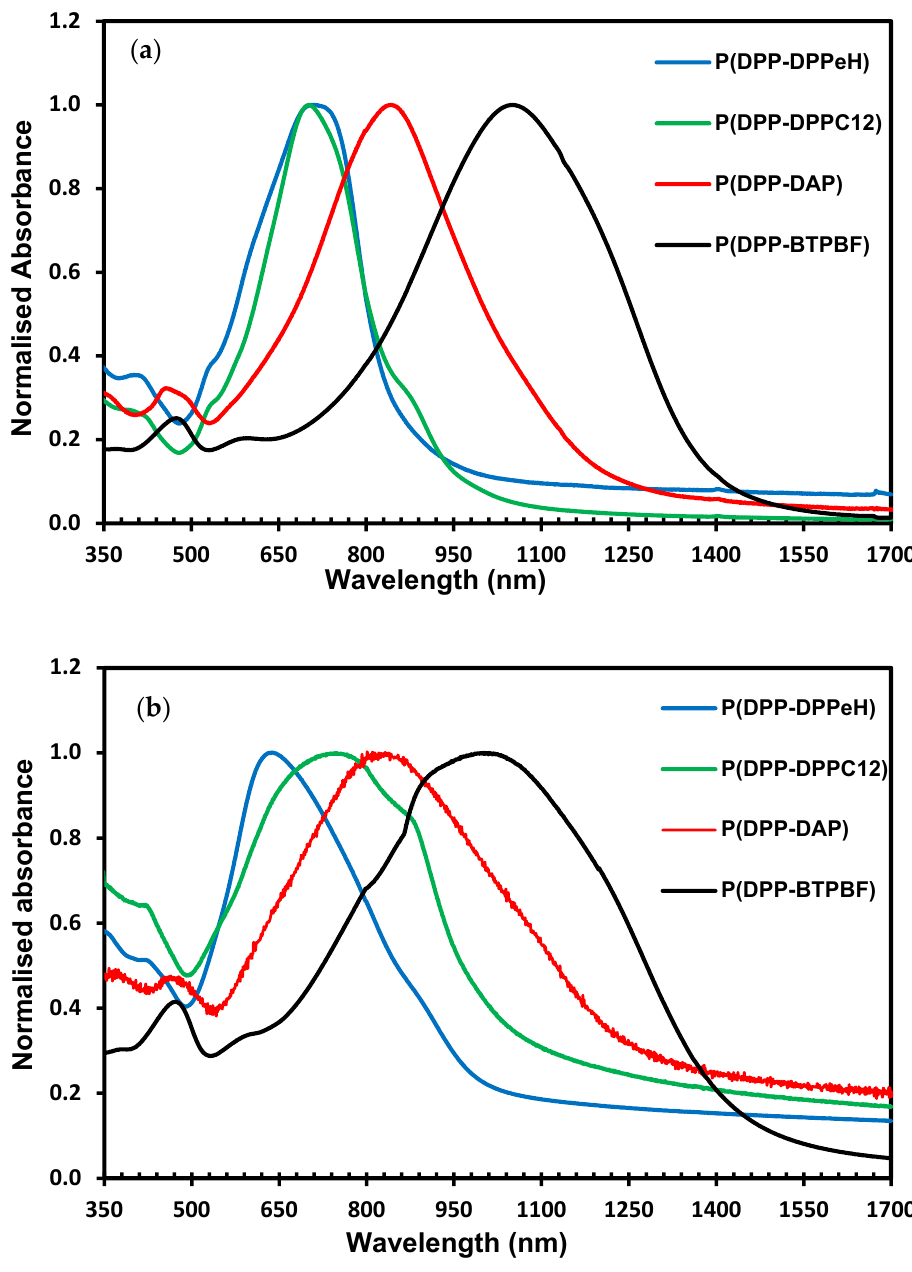
Figure 4. Normalized absorption spectra of A-A’ copolymers P(DPP-DPPeH), P(DPP-DPPC12), P(DPP-DAP), and P(DPP-BTPBF); ( a ) in chlorobenzene solutions; ( b ) in thin films (spin coated from chlorobenzene solutions). Table 2. Optoelectronic characteristics for monomers and copolymers.